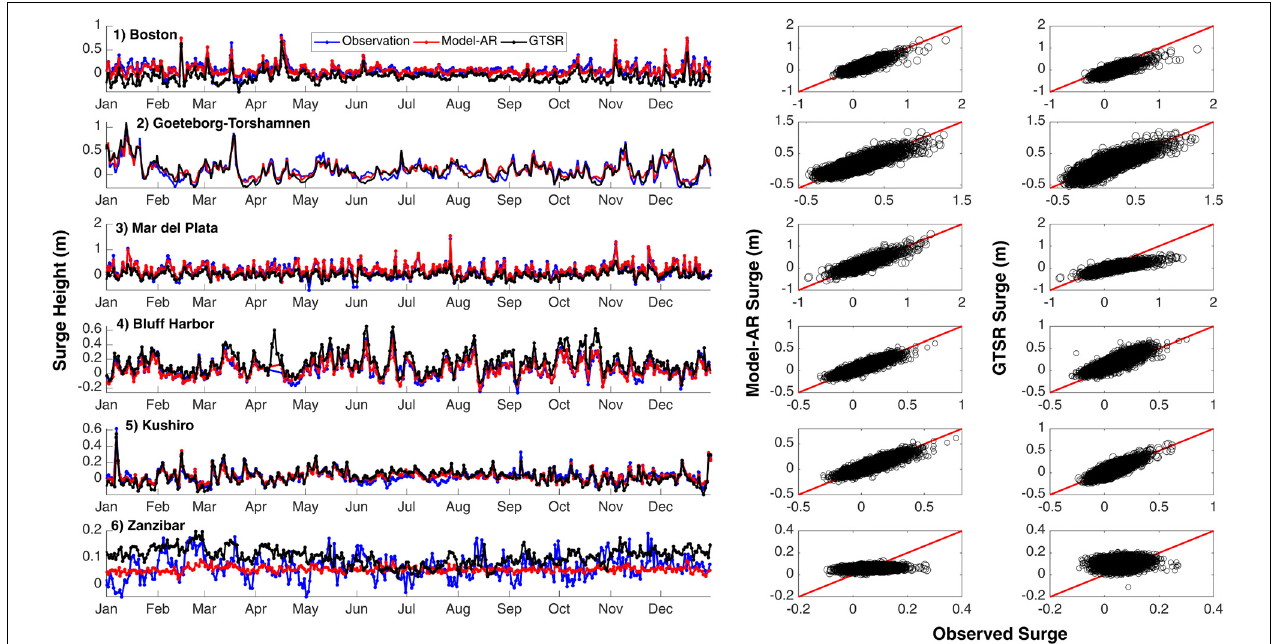
FIGURE 12 | Daily maximum surge time series comparison between observations, Model-AR, and GTSR (left); scatter plots for Model-AR and observed surge values (middle) and scatter plots for GTSR and observed surge values (right) for tide gages marked in yellow in Figure 1 .